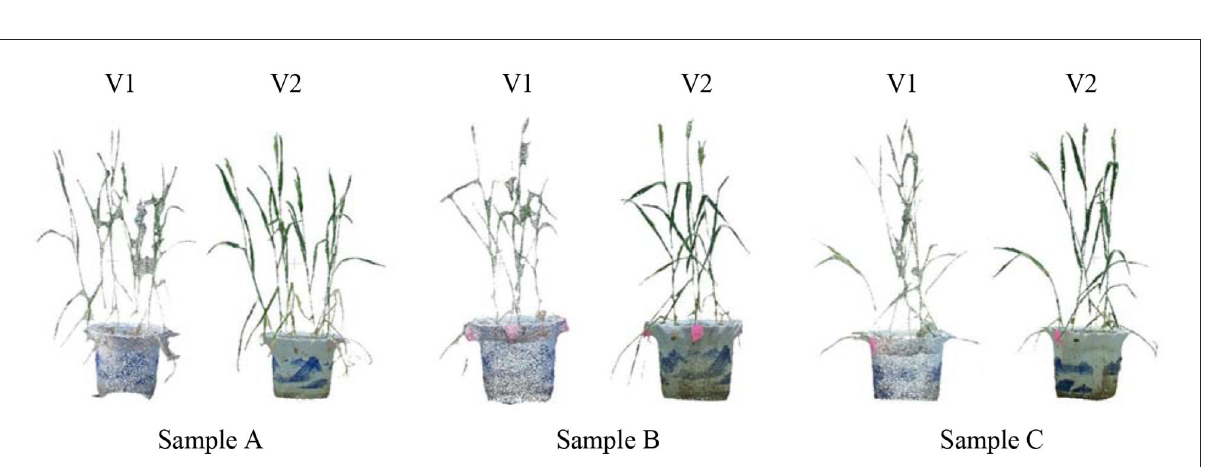
FIGURE8 Visualized comparison of reconstructed point clouds from the acquired multi-view images using two version MVS-Pheno platforms of randomly selected potted wheat plants. For each subfigure, the left and right ones were reconstructed from images acquired using MVS-Pheno V1 and V2,